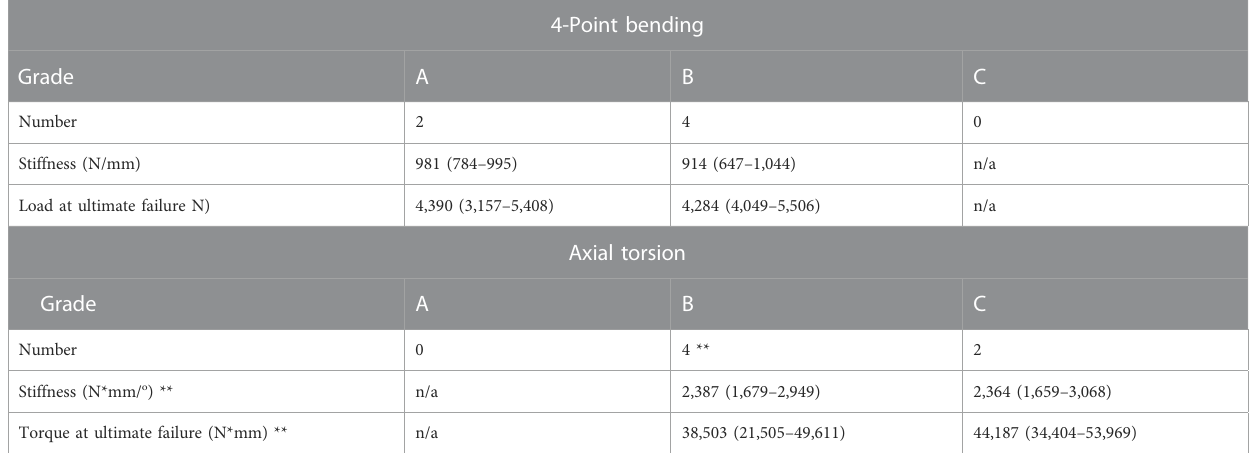
TABLE4Cementmantlegrade,whereAindicatescomplete fi llingofthemedullarycavitybycement belowthelessertrochanterwithnoradiolucencyatthebone- cement interface, B indicates radiolucency up to 50% of bone-cement interface, C indicates radiolucency at 50% – 99% of the bone-cement interface or defective/ incompletecementmantle,andDindicatesradiolucencyat100%ofthebone-cementinterfaceornocementpastthetipofthefemoralcomponent.NoCFXstems had grade C or D cement mantles in the 4-point bending group and no CFX stems had grade A or D cement mantles in the axial torsion group. Cement mantle grade did not appear to affect stiffness or load at failure. *Only 3/4 CFX implanted femurs with cement mantle grade B failed during torsional testing so the reported ultimate failure has n =